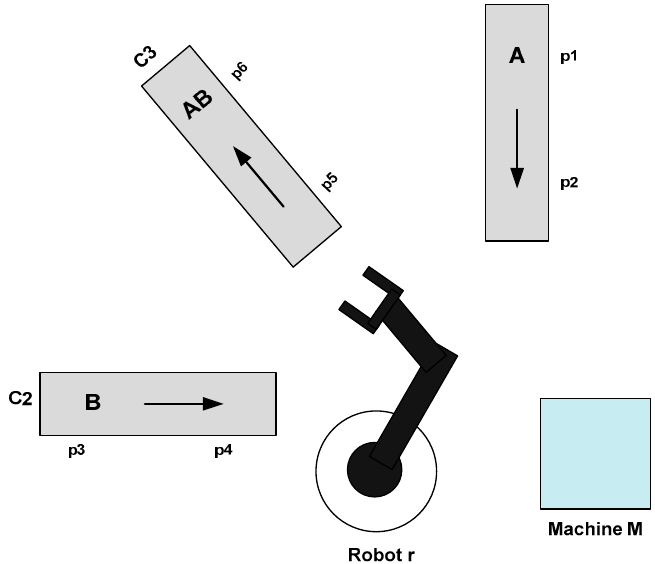
Figure 1. The benchmark production system RARM.